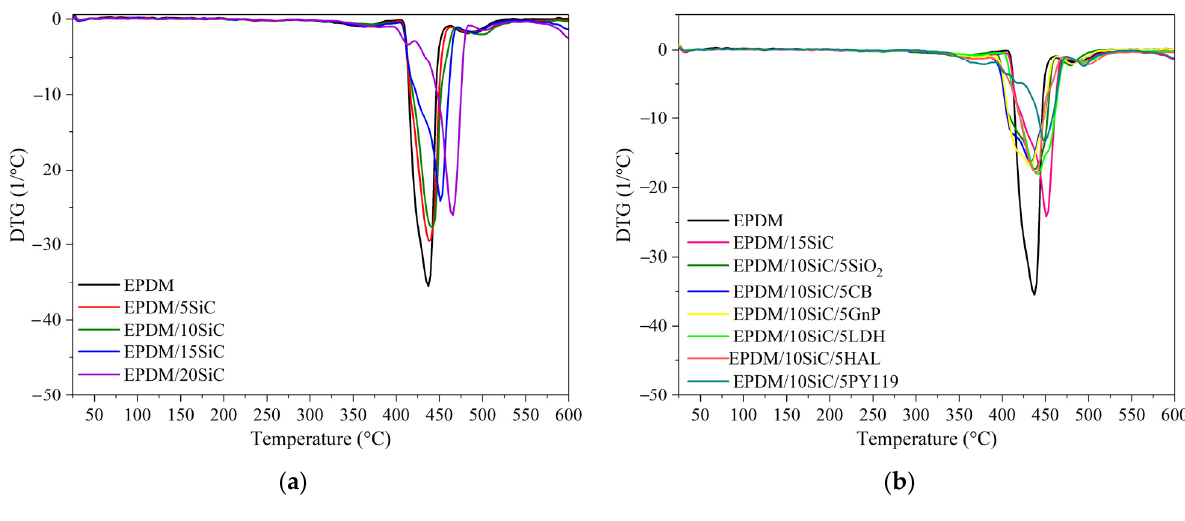
Figure A2. DTG curves of the EPDM composites filled with: ( a ) different concentrations of SiC and ( b ) different hybrid SiC filler systems.